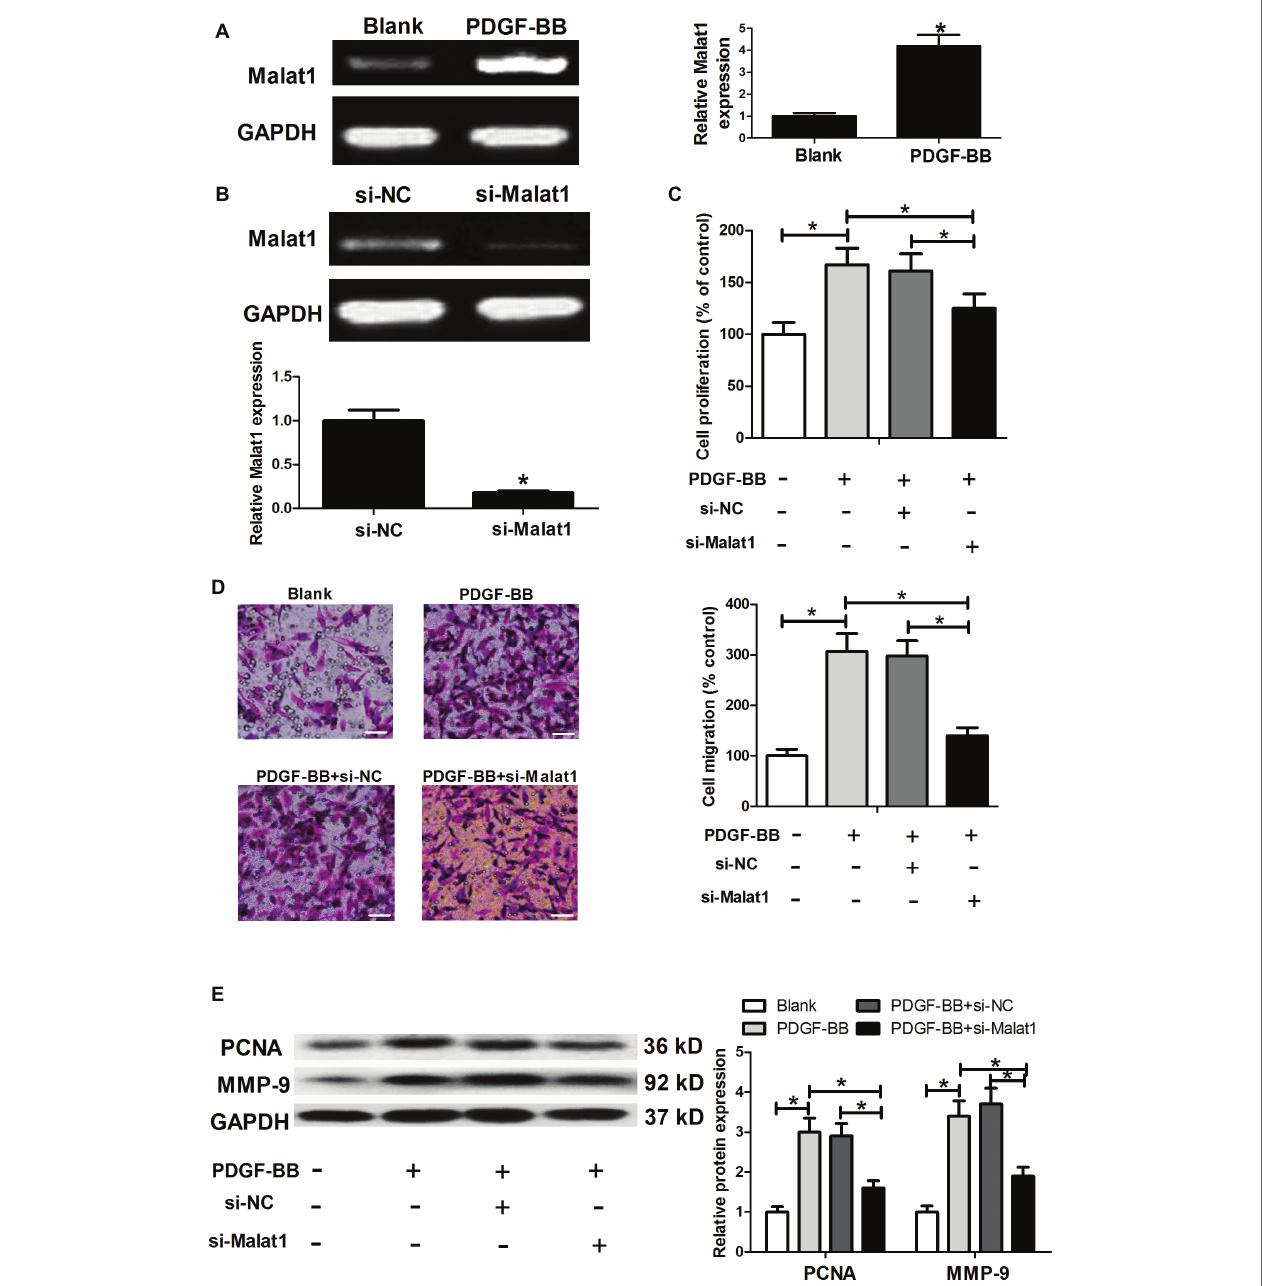
FIGURE 1 | Malat1 is upregulated in ASMCs stimulated with PDGF-BB, and Malat1 knockdown inhibits PDGF-BB-induced ASMC proliferation and migration. (A) Malat1 expression in ASMCs treated with PDGF-BB determined by RT-PCR. (B) Malat1 expression in ASMCs transfected with si-Malat1 or si-NC determined by RT-PCR. (C,D) The effect of Malat1 on PDGF-BB-induced ASMC proliferation and migration assessed by MTT and Transwell assays, respectively (scale bar: 100 μ m). (E) The effect of Malat1 on PCNA and MMP-9 expression in PDGF-BB-treated ASMCs determined by western blot assay. * p <